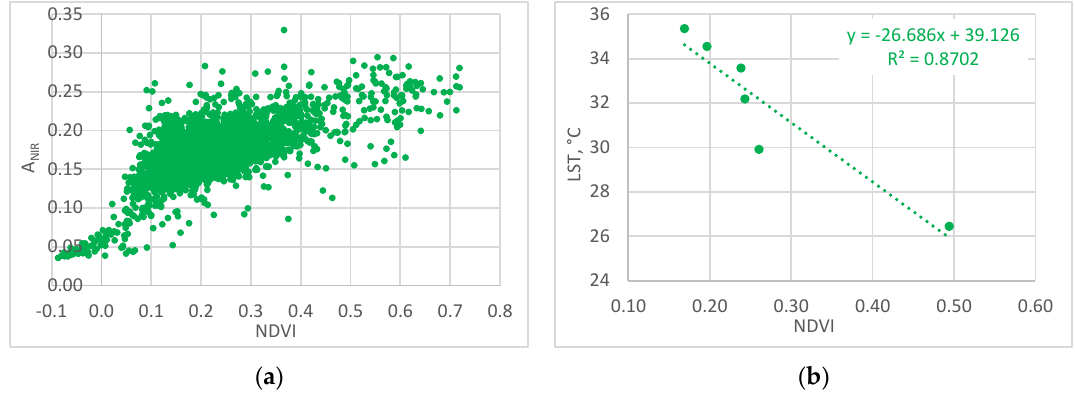
Figure 21. The correlations between NDVI and ( a ) A NIR (global data); and ( b ) LST (aggregated data).